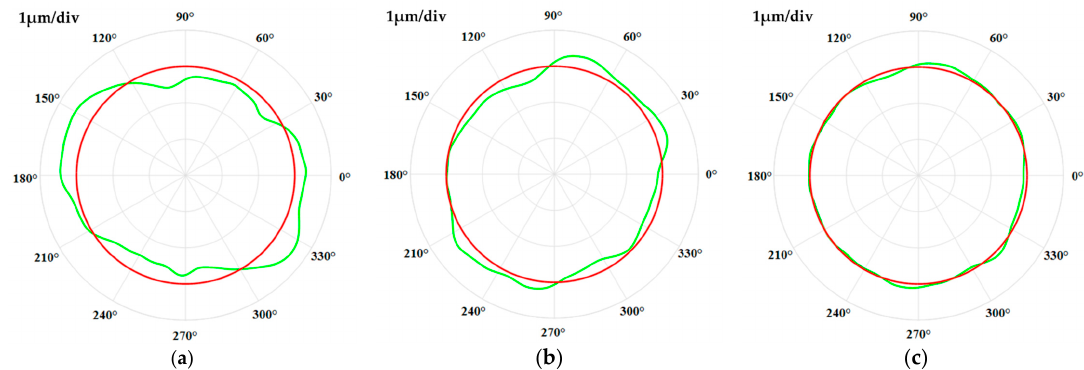
Figure 15. The shape of a circular contour at the same axial position: ( a ) Before figuring; ( b ) after figuring once; ( c ) after figuring two times.